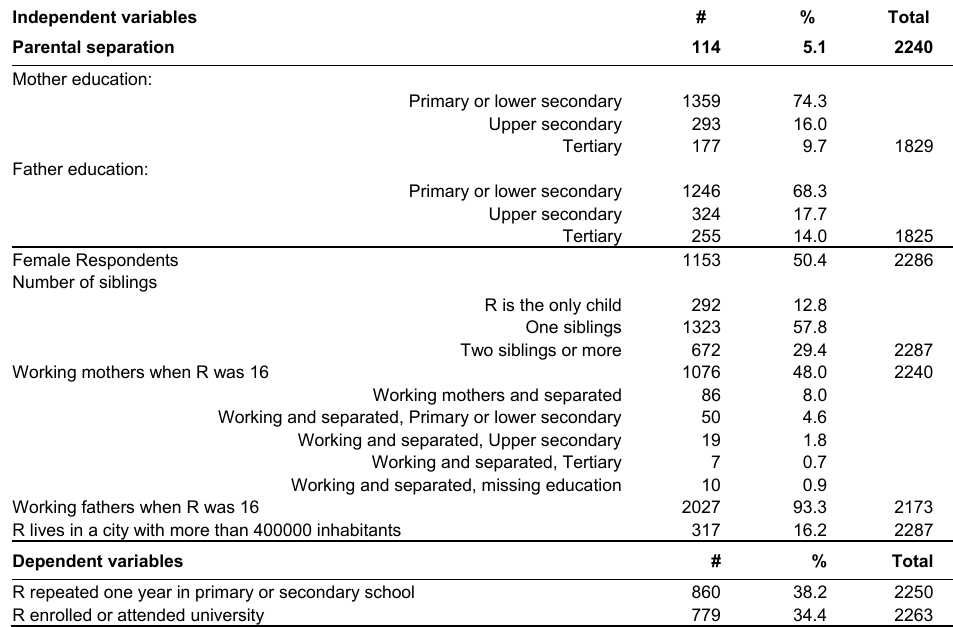
Descriptives. Respondents born after 1965 to Spanish